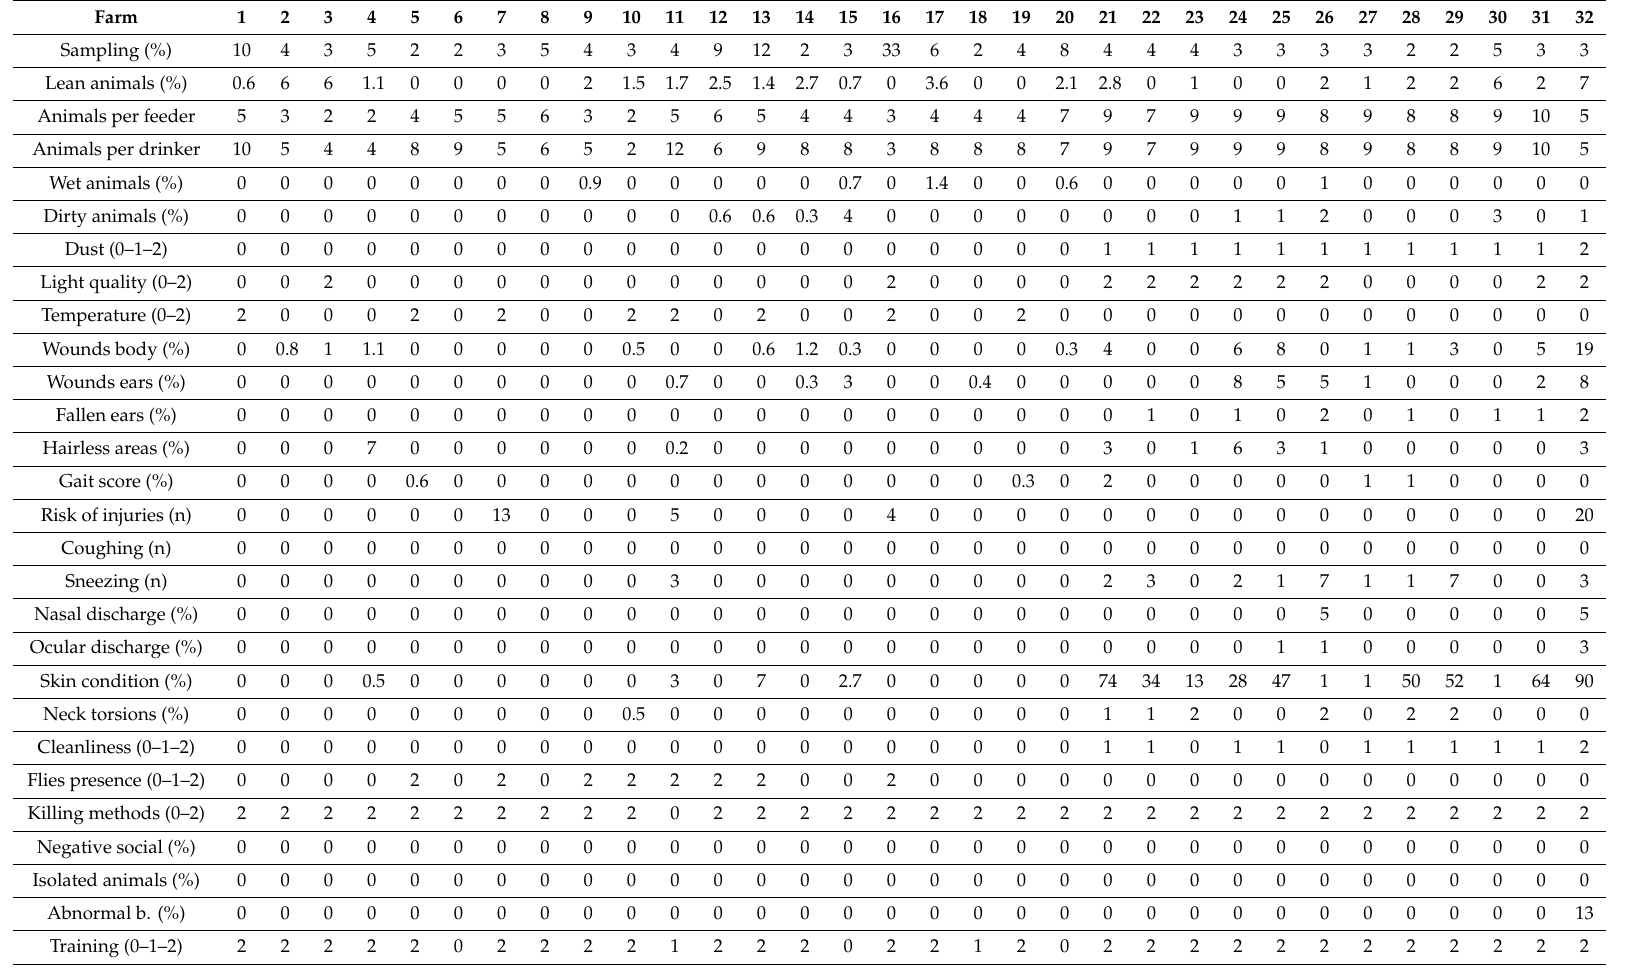
Table 6. Sampling used (% of the animals assessed out of the total present in the farm) and the results found for di ff erent parameters in farms 1 to 32 of growing-rabbits reared for meat production. (%) is the percentage of animals a ff ected out of all the assessed animals. 0 means excellent situation, 1, acceptable situation (moderate problems) and 2, not acceptable situation (severe problems). (n) is the number of cages a ff ected from a total of 20 to 50 cages assessed. Farm